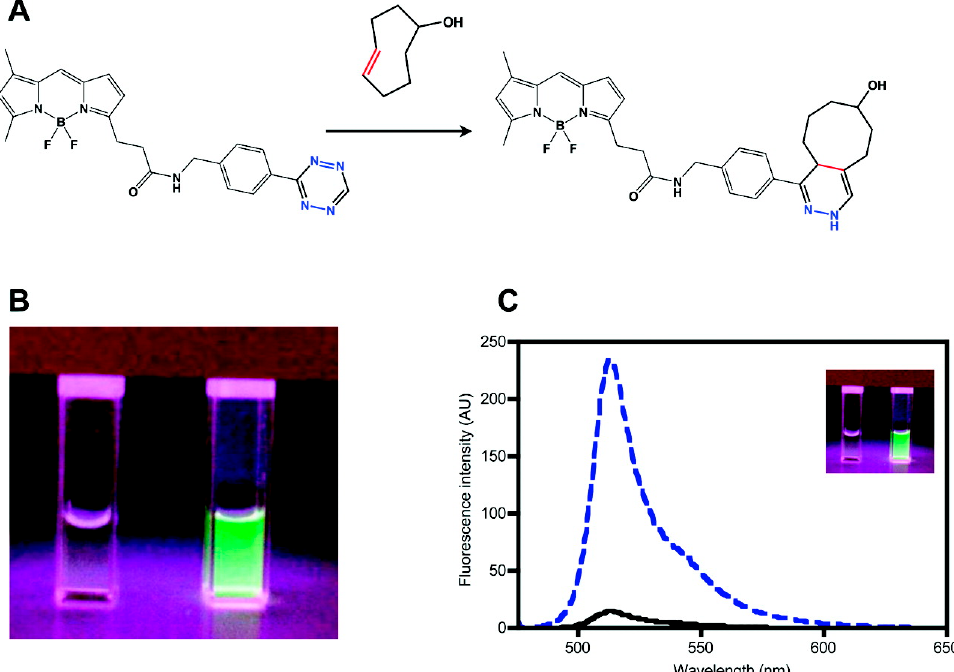
Figure 1. Synthesis of a tetrazine-functionalized fluorophore via Förster resonance energy transfer (FRET). ( a ) Schematic representation of the reaction between trans -cyclooctenol and tetrazine-BODIPY-FL (BODIPY = 4,4-difluoro-4-bora-3a,4a-diaza-s-indacene) via an inverse electron demand Diels–Alder (iEDDA) reaction. ( b ) and ( c ) Fluorogenic properties of tetrazine–BODIPY-FL. Comparison of the image ( b ) and emission spectrum ( c ) of tetrazine–BODIPY-FL (left cuvette and black line, respectively) and the corresponding dihydropyrazine product (right cuvette and dashed blue line, respectively). Reproduced with permission from [36]. Copyright (2018) American Chemical Society.